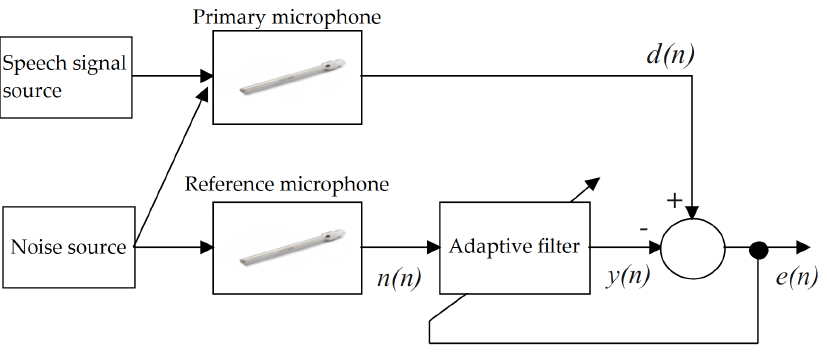
Figure 5. General block diagram of an adaptive